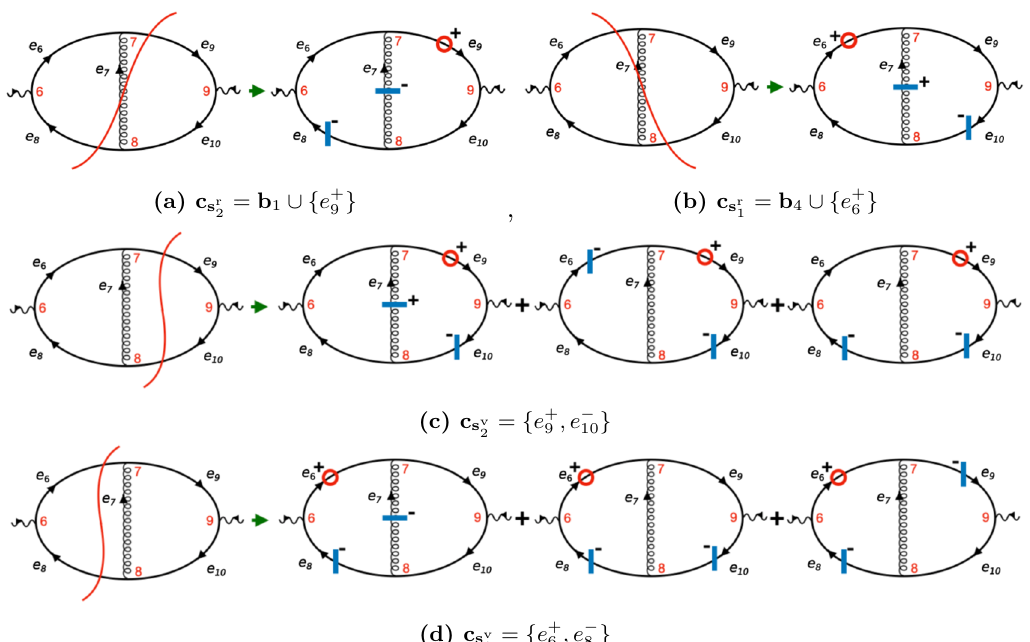
Figure 4. Explicit correspondence between the four Cutkosky cuts of the double-triangle super- graph and the causal threshold surfaces of its 2-loop LTD representation. The loop momenta bases b i that are absent from this figure correspond to summands of the LTD expression that contain no E-surface. The propagators circled in red are the ones inducing the causal threshold singularity when becoming on-shell (with a positive or negative on-shell energy depending on the sign above the red